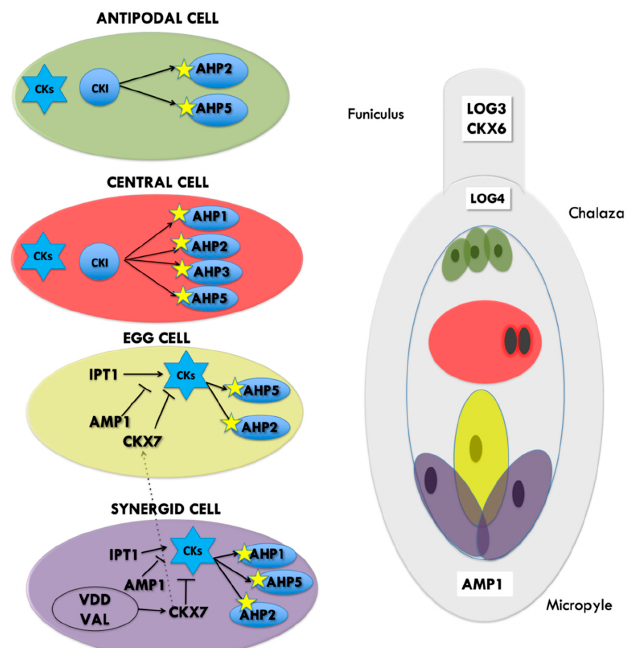
Figure 3. Arabidopsis mature female gametophyte and CKs involvement. The specific localisation and different relationships among CK biosynthesis, degradation and signalling components within the mature FG determine the identities and functions of each cell of the embryo sac. The signalling component AHP1 is present in the central cell and the synergid cells ; instead, AHP2 and AHP5 are expressed in all the gametophytic cells and AHP3 is specifically localized in the central cell. CKI1, cytokinin-independent kinase is specifically expressed in the antipodals and central cells, interacting with the present AHPs. The components involved in CK biosynthesis and degradation genes, IPT1 and CKX7, respectively , are mainly active on the opposite side of the embryo sac, towards the micropyle. Intriguingly, CKX7 promoter activity is detected in synergid cells and the protein in the egg cell. Components of CK biosynthesis and degradation are mainly expressed in the sporophytic tissues surrounding the mature ovule such as LOG3 that is expressed in the funiculus, as well as degradation components, CKX6. Instead, LOG4 that is expressed in the integuments at the chalaza side . AMP1 is expressed in the ovule integuments in the synergids and weekly in the egg cell, AMP1 controls the content of CKs. VDD and VAL REM transcription factors are expressed both in synergid cells and control directly and/or indirectly the expression of CKX7 . In purple are distinguished synergid cells, in yellow the egg cell, in red the central cell, in green the antipodals and in grey the sporophytic tissues surrounding the female gametophyte. Yellow stars represent the phosphoryl group. (CKs)